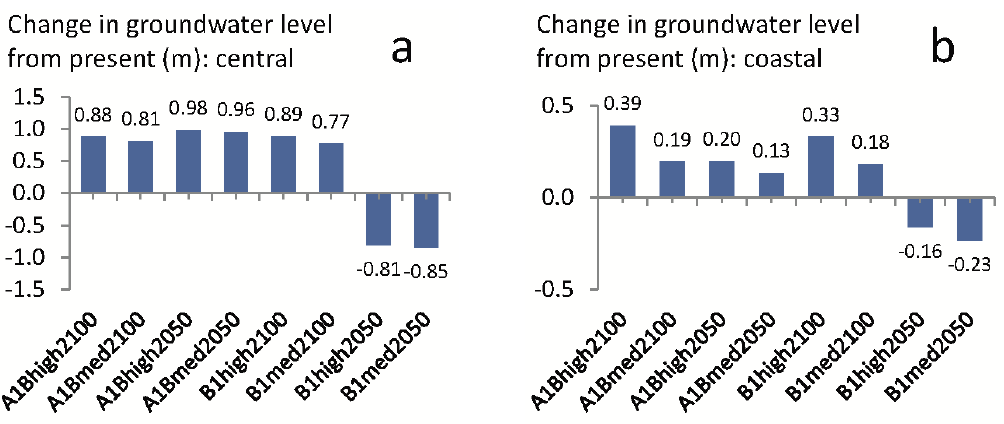
Figure 13. Changes in mean annual groundwater level in simulation results for the A1B